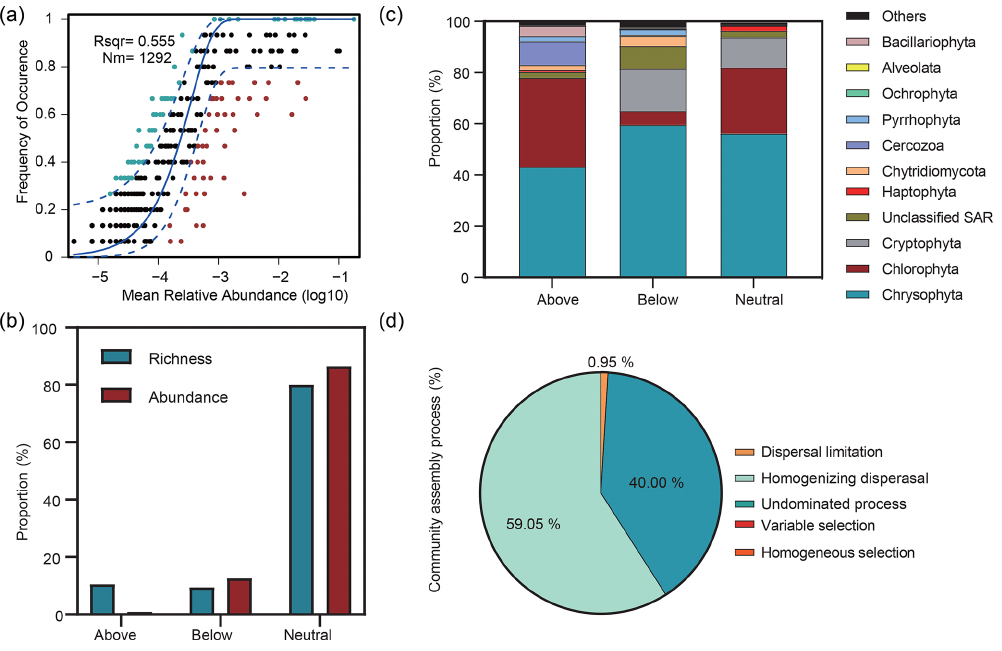
Figure 6. Relative influences of deterministic and stochastic processes on microbial eukaryotic community assembly based on the neutral community model (NCM) and the null model. (a) Fit of the NCM of community assembly. Nm indicates the metacommunity size, and R 2 indicates the fit to the NCM. Neutral prediction was within a 95% confidence interval (black), while non-neutral processes included the above and below prediction (dark green and red). (b) Proportions of the richness and abundance of the three groups (above prediction, below prediction, and neutral prediction) based on the NCM. (c) Abundance composition of the three groups in the microbial eukaryotic community. (d) Null model analysis revealing the fraction of ecological processes. The percent of community assembly is governed primarily by various deterministic processes, such as homogeneous and variable selections, and stochastic processes, including dispersal limitations, homogenizing dispersal, and undominated processes (i.e. weak selection, weak dispersal, diversification, and drift